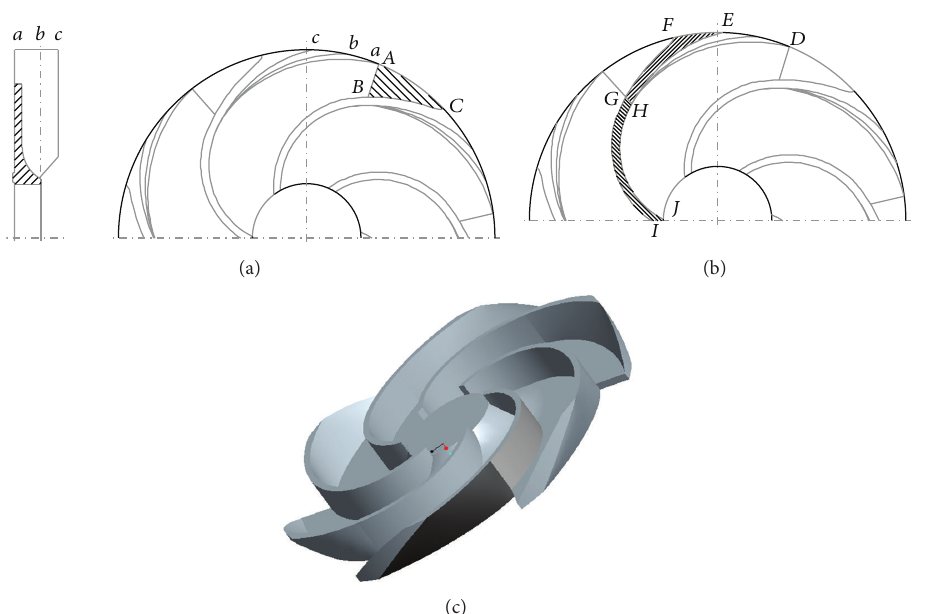
Figure 4: Blade design procedure: (a) schematic of a new RGV, (b) two parts of RGV, and (c) 3D view.